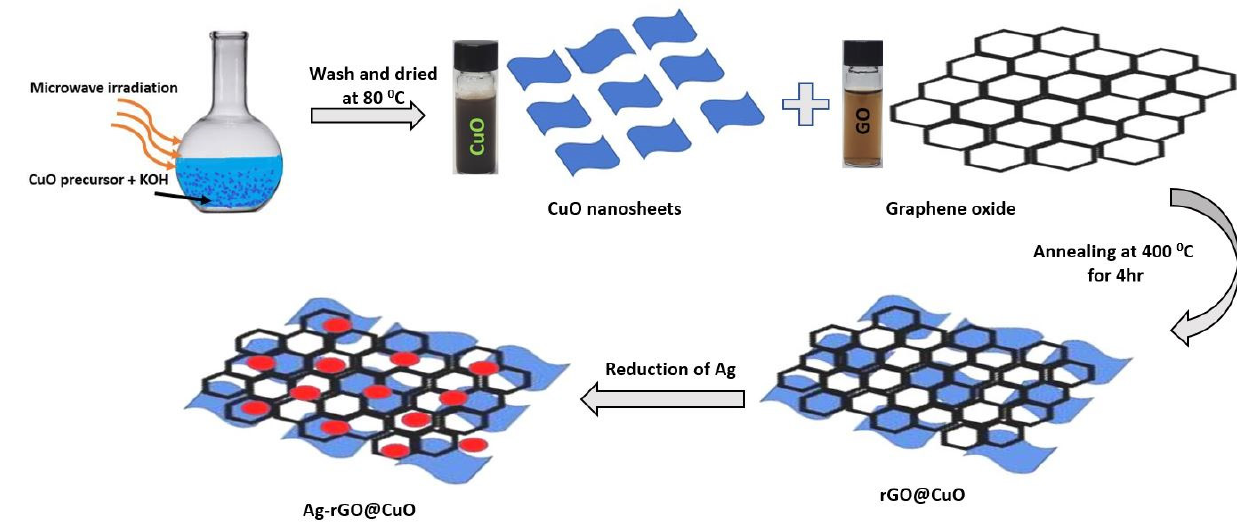
Figure 1. Schematic diagram representing the fabrication of Ag-rGO@CuO nanocomposite. Pure CuO nanosheets were synthesized by a microwave-assisted hydrothermal